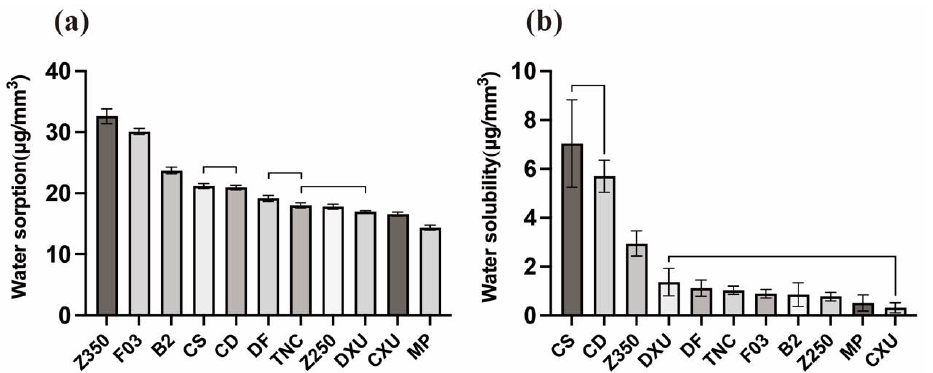
Figure 4. Bar graph illustrating mean water sorption and water solubility values of the composite resins. Groups underneath a line do not differ significantly: ( a ) water sorption ( b ) water solubility. Table 4. Means and SD of water sorption and solubility (µg/mm 3 ) for the tested composite resins. Material